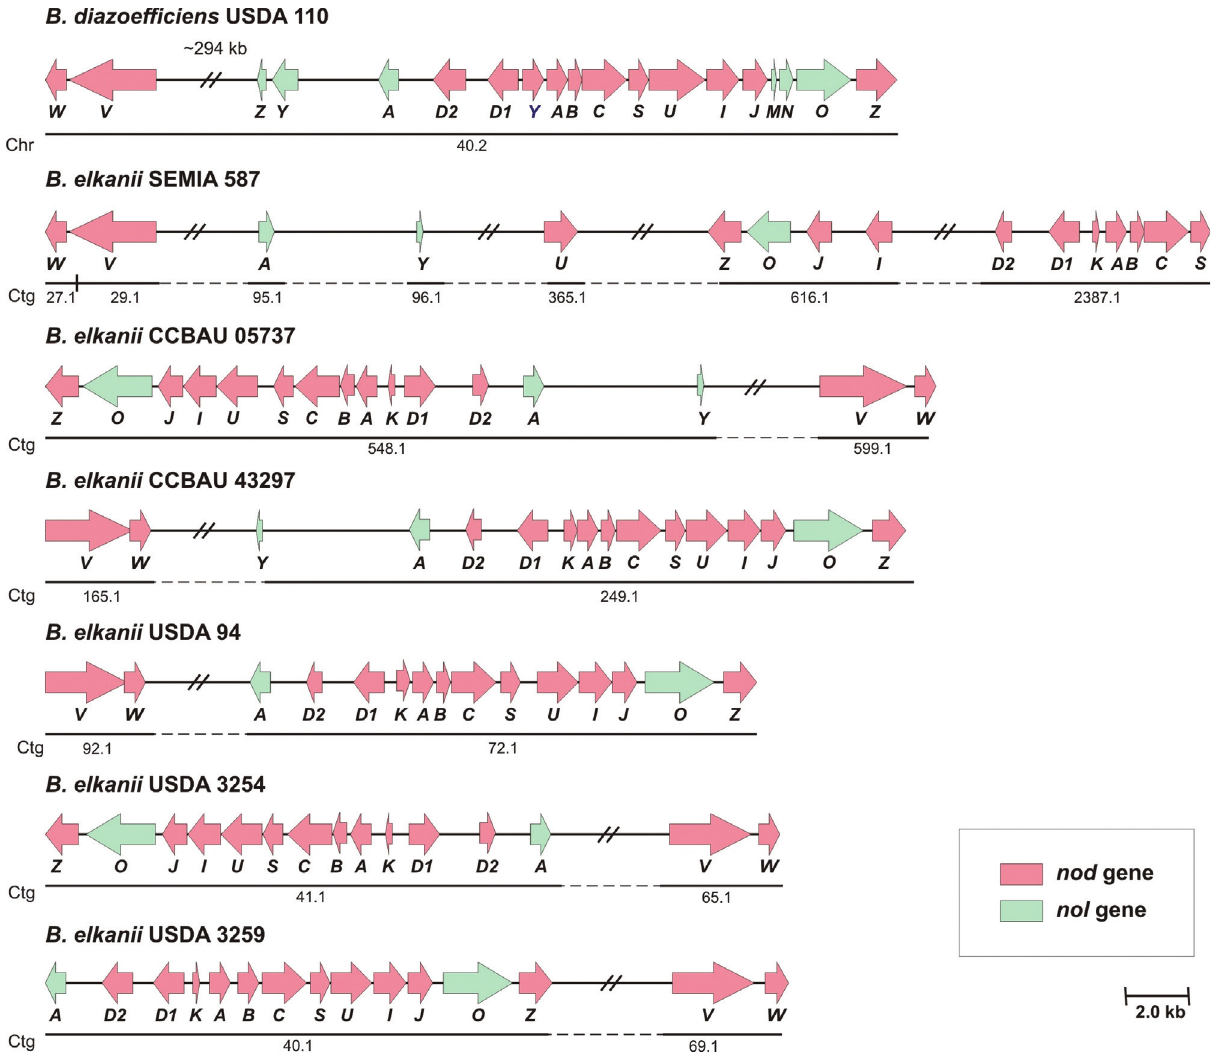
Figure1 -Geneticmapshowingorganizationofthe nod / nol genesin B.diazoefficiens USDA110(referencegenome)andsix B.elkanii genomes.Letters indicate the name of each gene in the genome. Gene classes are color coded and transcriptional orientation is indicated by the arrows. Relative gene dis- tances are indicated or follow the scale presented. Gene location within the genome is represented by a straight line below the gene map of the respective chromosome ( B. diazoefficiens ) or contig ( B. elkanii )